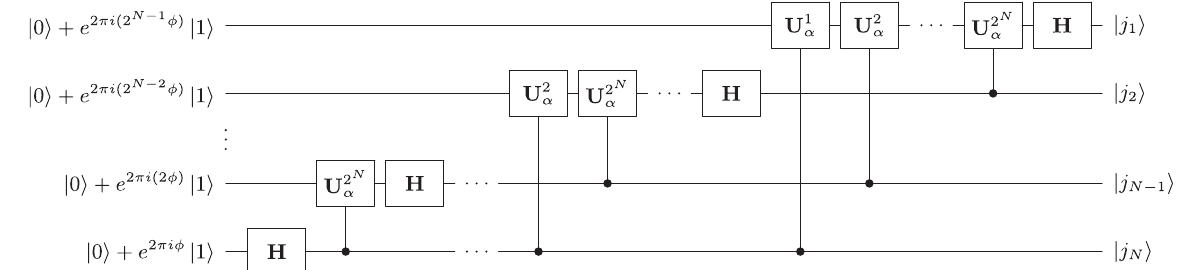
FIG. 6. Quantum phase estimation, inverse Fourier-transform stage. Here, α ¼ 2 − j ϕ j , as in Ref. [20]. This smallest angle α allows us to have only a finite set of gates in the Hamiltonian, instead of requiring an arbitrarily small gate with angle 2 − N . Note that this crucially depends on the ability to detect the least significant bit from the control-phase